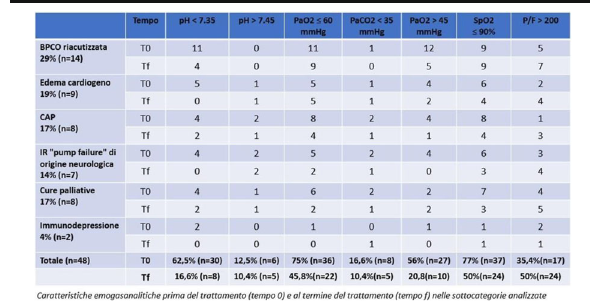
Table 4 (abstract A195). See text for description Table 1 (abstract A195). See text for